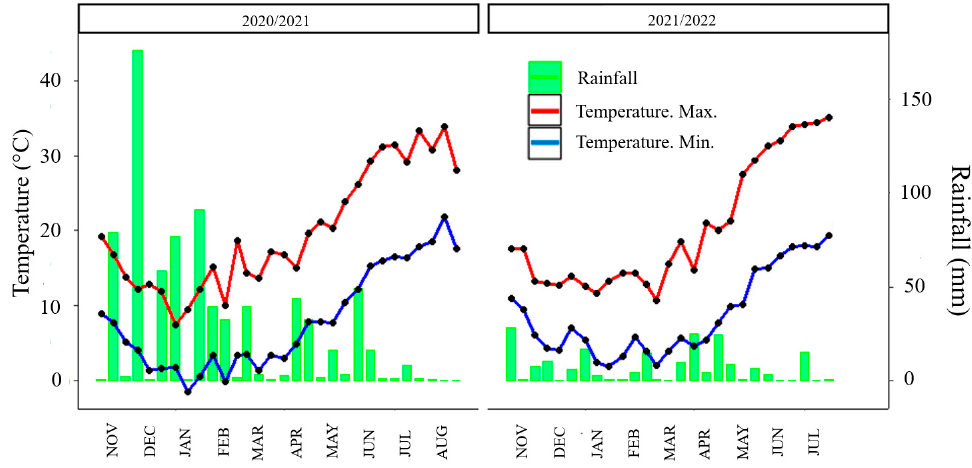
Figure 2. Minimum and maximum temperatures (°C), and rainfall (mm) at the experimental site, throughout the periods of study in 2021 and 2022.